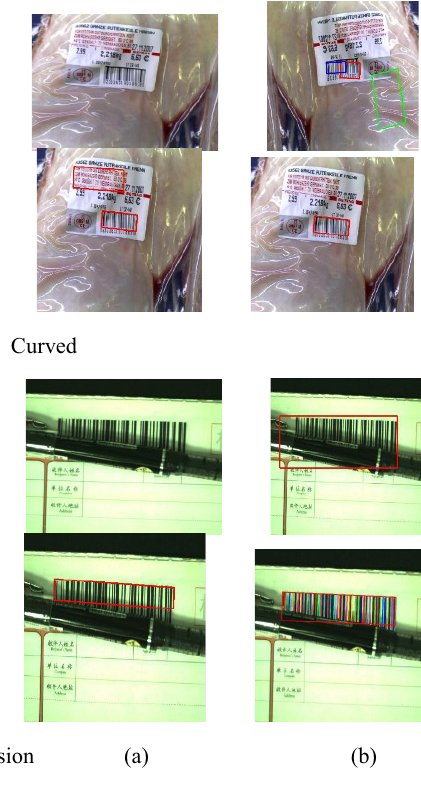
Figure 4. Comparison of experimental results with different